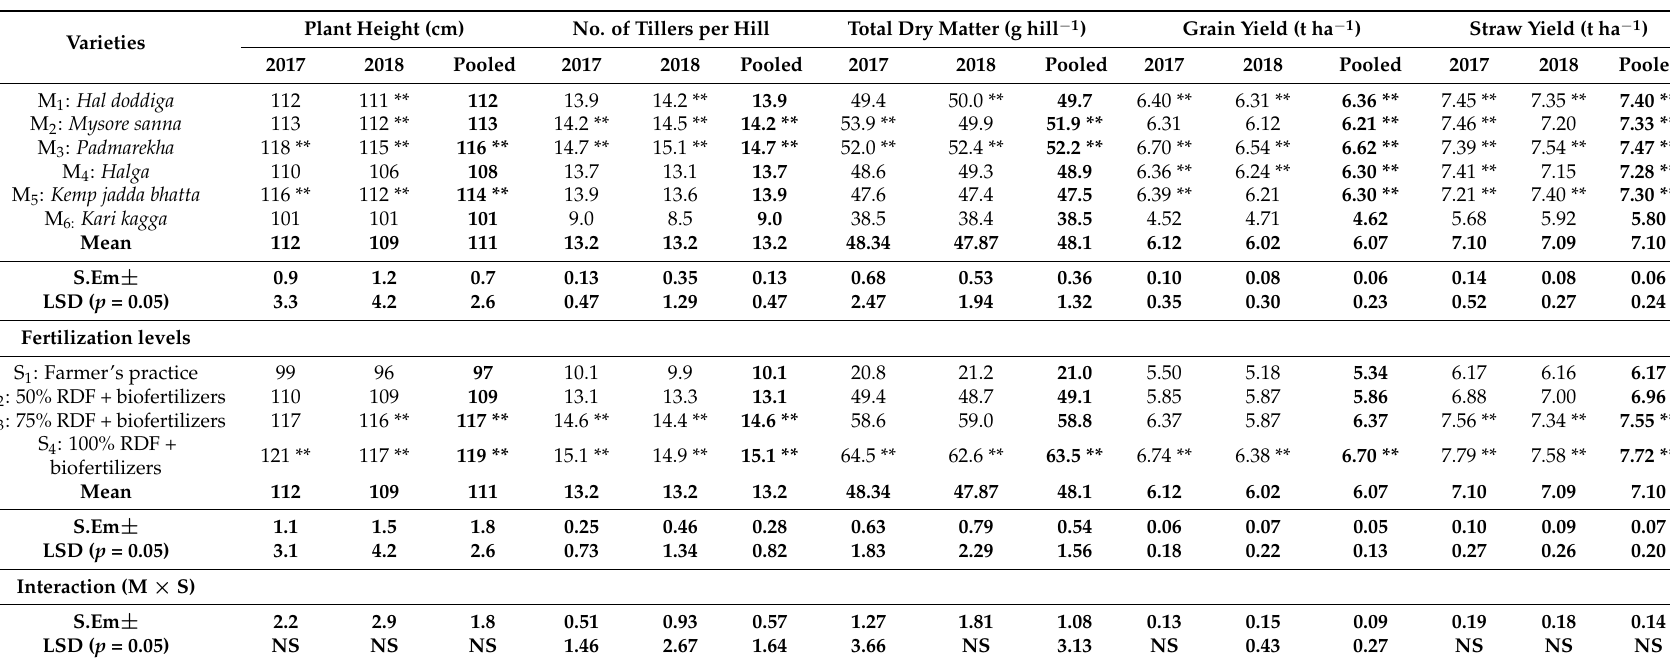
Table 1. Growth and yield of traditional paddy landraces as influenced by different fertilizer levels in conjunction with biofertilizer practices in the coastal areas of Kumta Taluk, Uttara Kannada district, Karnataka,